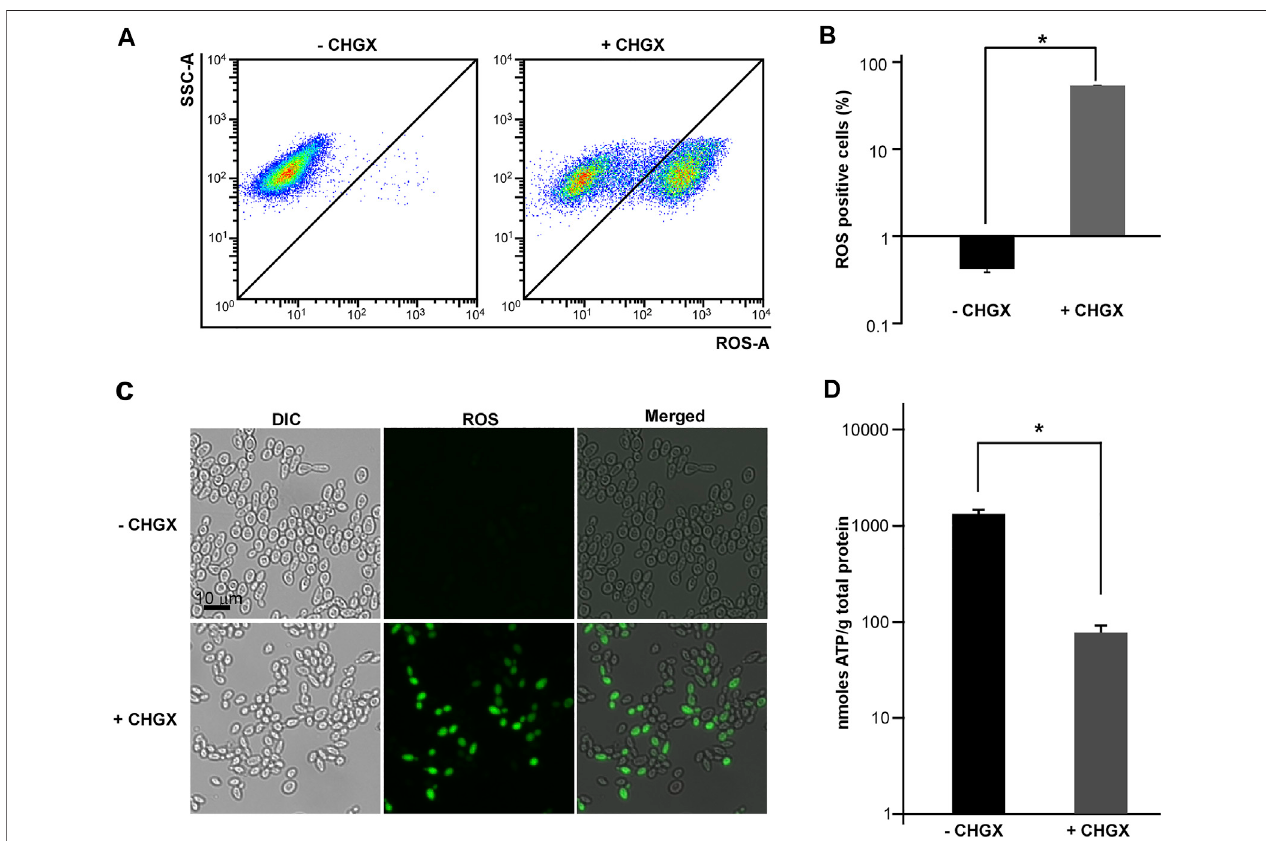
FIGURE 6 | The effects of CHGX water-extract on intracellular ROS production and ATP consumption by C. albicans . SC5314 cells were used for representative strain of C. albicans. SC5314 cells (2 × 10 6 cells/ml) were treated with or without 20 mg/ml CHGX water-extract in Lee ’ s glucose medium for 3 h at 30 ° C. (A – C) The intracellularaccumulationofROS.CellswereharvestedandincubatedwithDCFH-DAfor fl owcytometry (A) and fl uorescencemicroscopy (C) .SSC-A,sidescatterarea; ROS-A, ROS area. (B) The percentages of ROS-positive cells. The data were presented as mean ± SD of three independent experiments according to fl ow cytometry assay in panel A. (D) The level of intracellular ATP. Cells were harvested and homogenized in 1 × PBS for ATP assay by an ATP Bioluminescence Assay kit. Threebiologicalrepeatswereperformed,andthevaluesarepresentedasmean±SD.One-wayanalysisofvariance(ANOVA)wasusedtocomparedifferencesbetween CHGX water-extract treated and untreated samples as indicated; *, p <